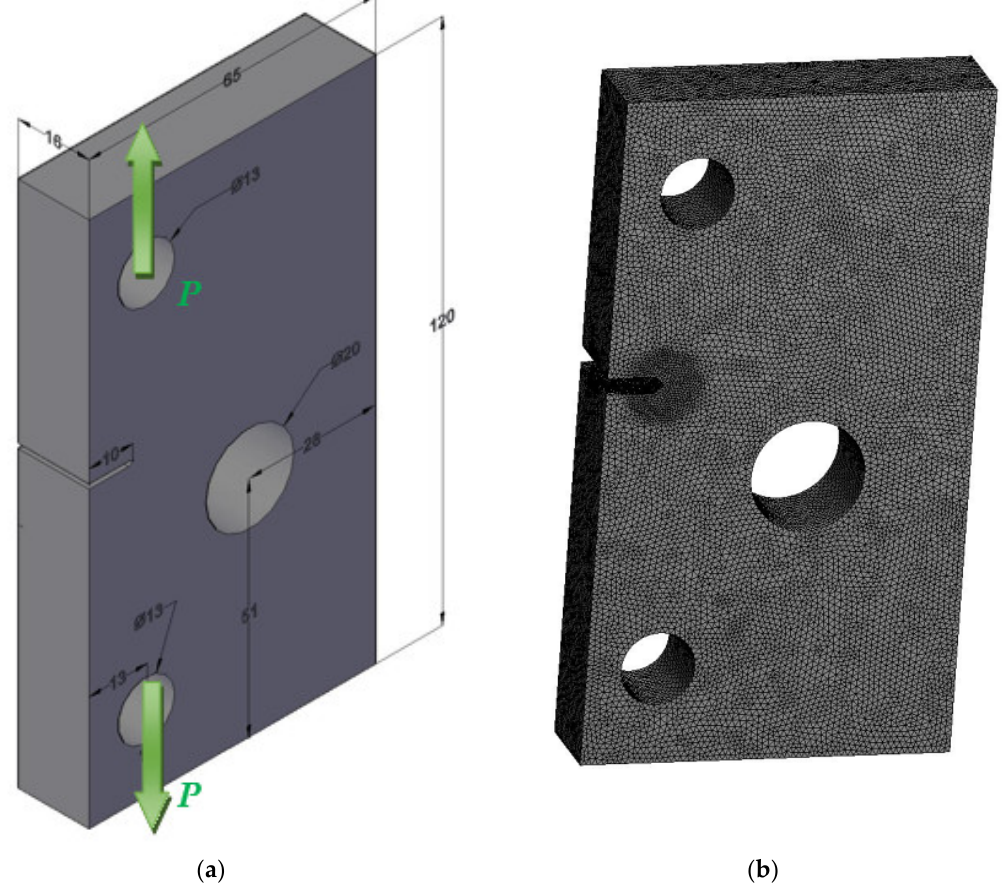
Table 2. Materials properties for aluminum 7075-T6.